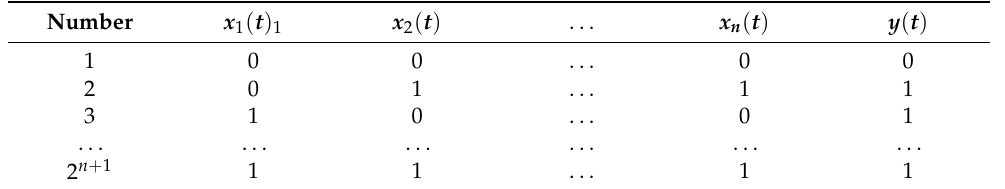
Table 3. The quantitative operation rules of the AND